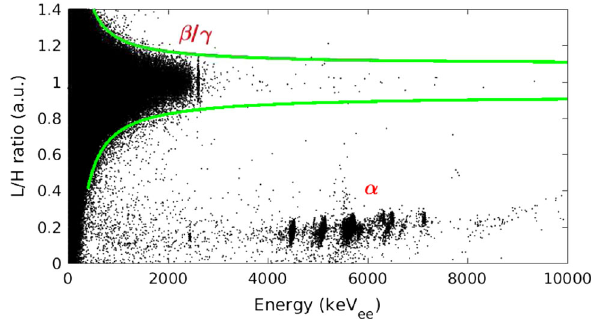
Fig. 6 Scatter plot of the rise time vs energy deposited in a phonon channel. The β/γ band and the α clusters are clearly separated, as labelled in the